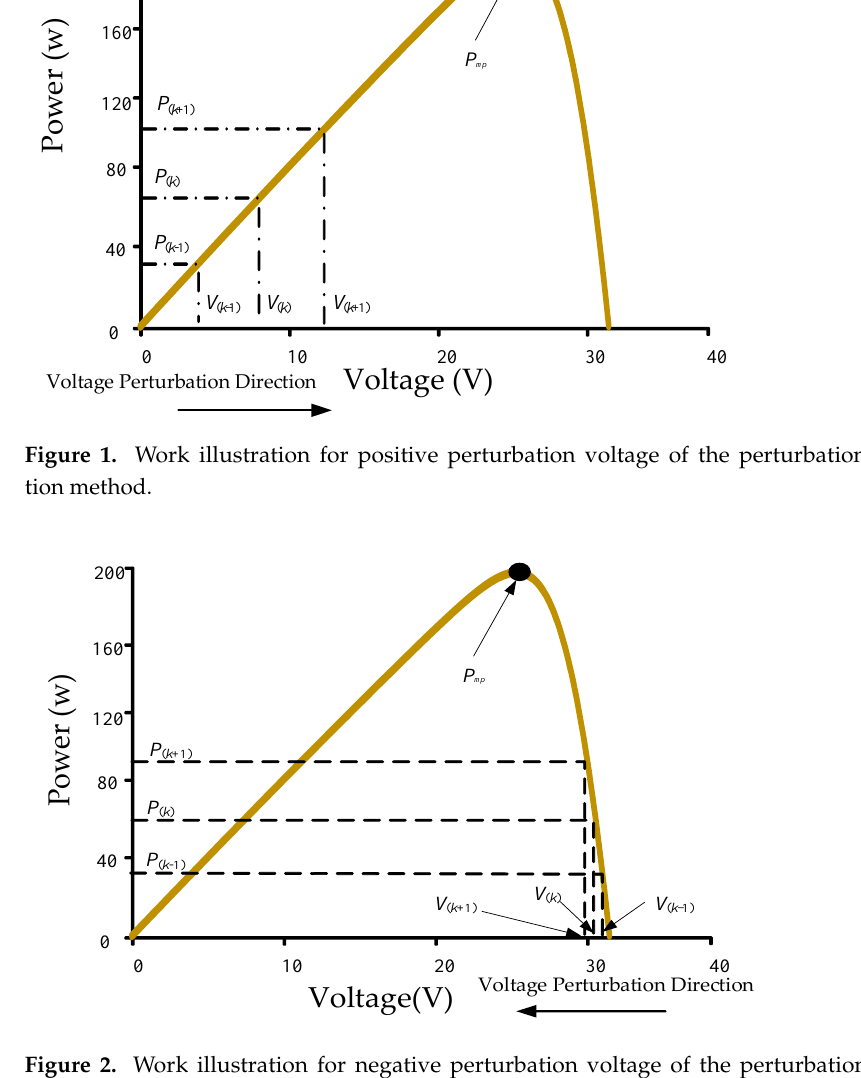
Figure 3. Circuit architecture of boost converter. The boost converter in this paper is designed with a duty cycle D of the switch for 0~1, which enables the inductor current to work in a continuous conduction mode (CCM). It can be deduced from reference [10] that the inductance value of the boost converter must satisfy the condition of Equation (1). However, the function 𝐷(1 − 𝐷) 2 in Equation (1) has a maximum value when D = 1/3. Therefore, it can be known from Equation (1) that if the inductance current is to operate in current CCM when the duty cycle D is between 0 and 1, the required inductance value L is the maximum when D = 1/3. Therefore, the inductance value is the required value when D = 1/3. The converter can be operated in current CCM under all duty cycles. The boost converter used for switching frequency f is 20kHz, rated power P is 1800W, and the maximum output voltage V o is 400V, so the re- sistance value of the load R can be calculated from R = V o2 /P is 89Ω. Therefore, according to Equation (1), when D = 1/3, the required L value can be calculated as 330μH, and then multiplied by 1.25 times the margin to ensure that the inductor current can be operated in CCM. Therefore, the inductor value chosen in this paper is 0.5mH.